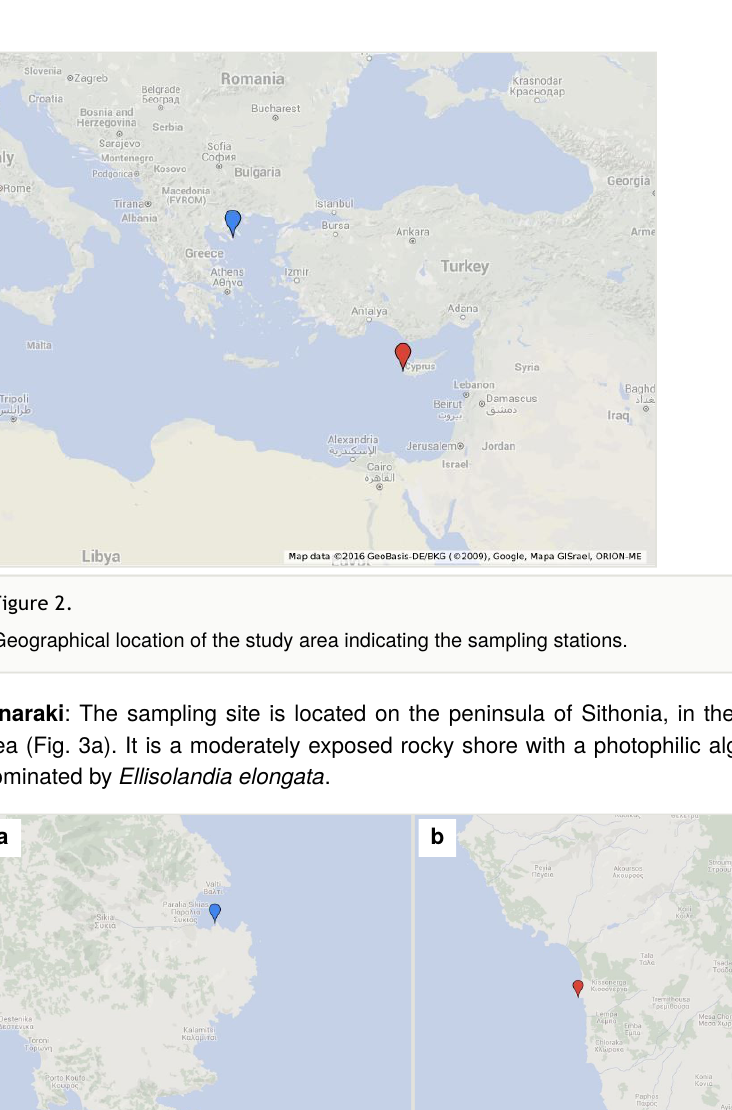
Location of the sampling station